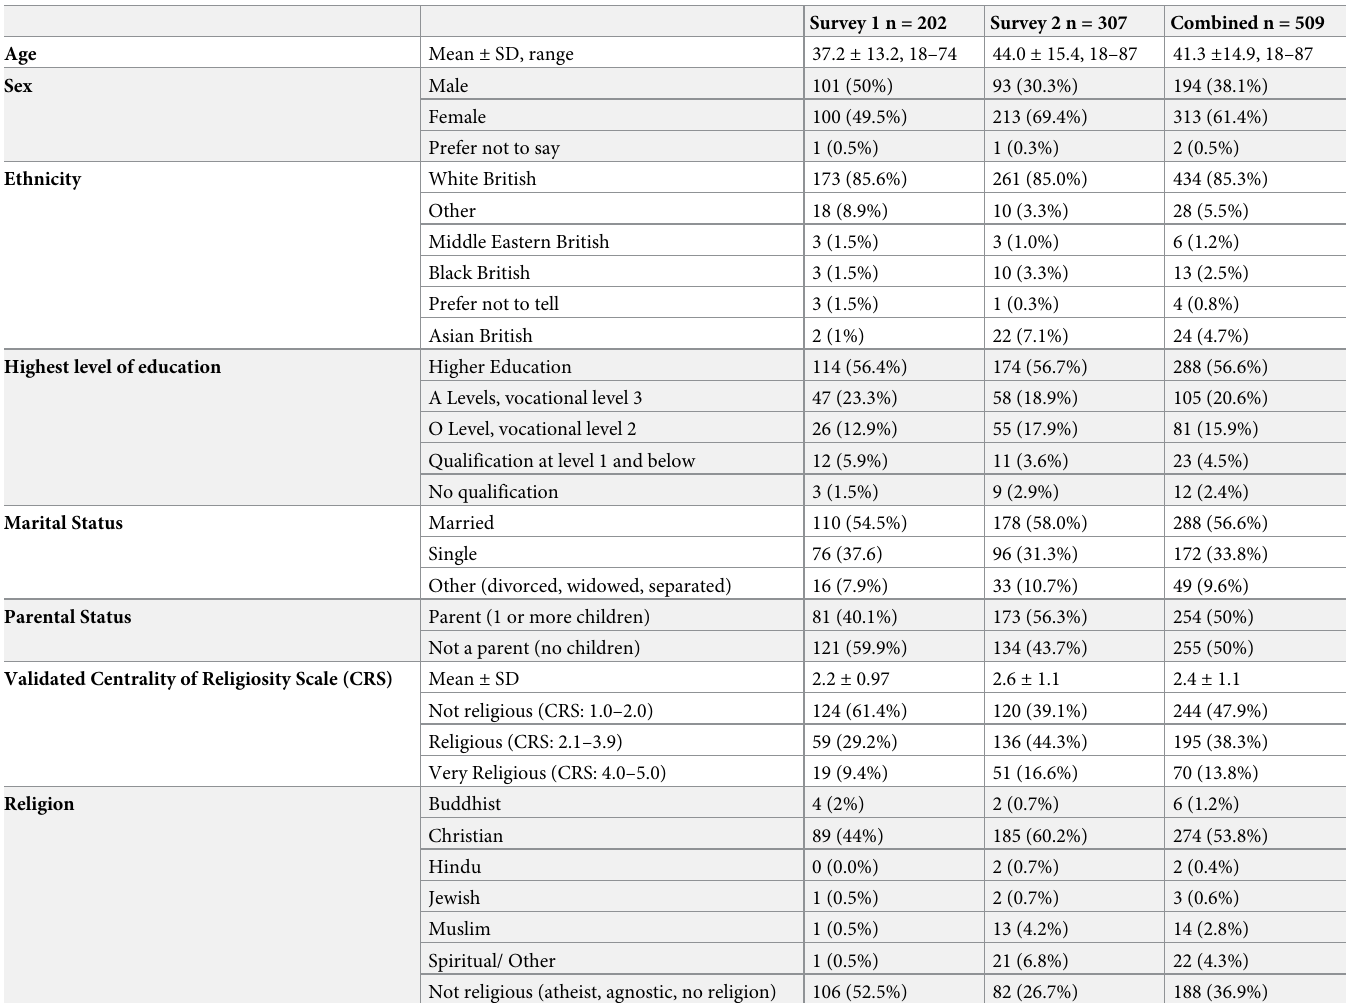
Table 1. Demographic characteristics of